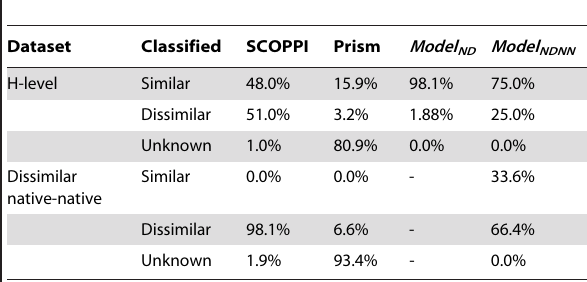
Table 6. Comparison of SCOPPI, PRISM with Model ND and Model NDNN .